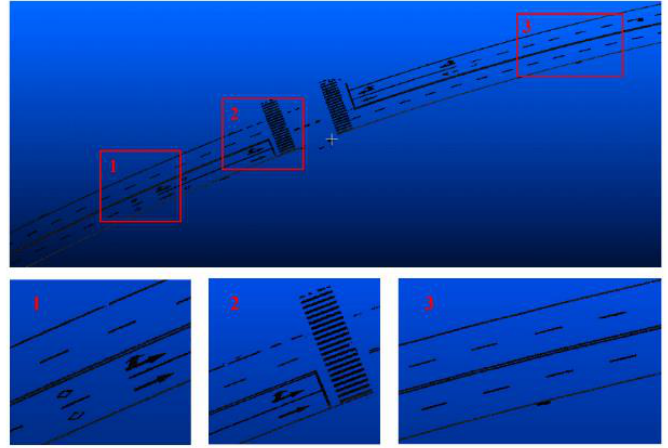
Table 2. Parameters of road marking extraction.